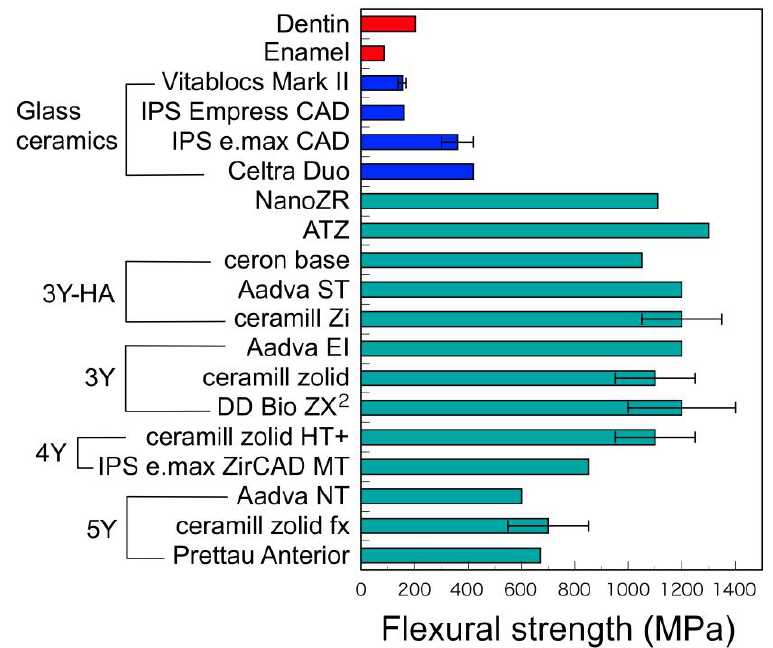
Figure 12. Flexural strength of tooth substance and CAD/CAM materials. Adopted from manufac- turers indication.